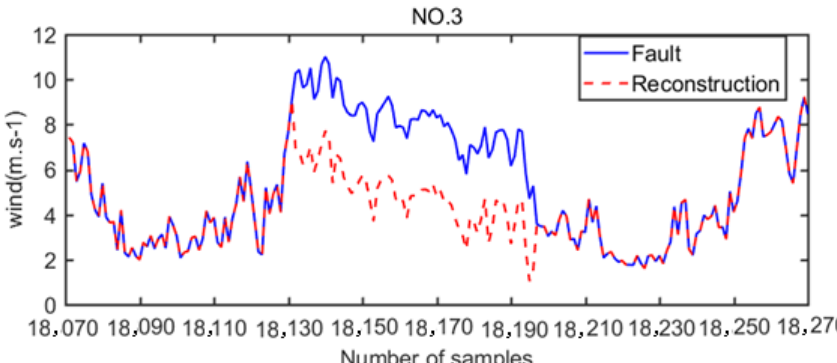
Figure 12. The actual power and theoretical power of anemometers for six wind turbines in 2016: ( a ) Power curve of WTG1; ( b ) Power curve of WTG2; ( c ) Power curve of WTG3; ( d ) Power curve of WTG4; ( e ) Power curve of WTG5; ( f ) Power curve of WTG6